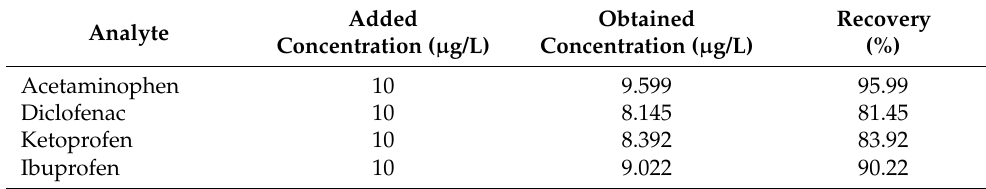
Table 5. The accuracy of the analytical method.